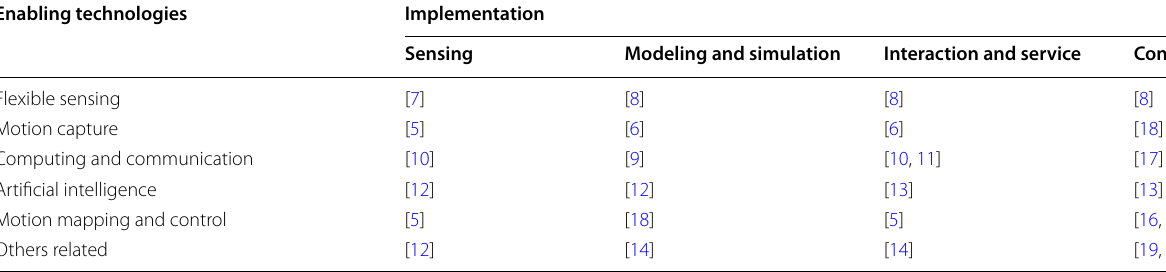
Table 1 Illustration of implementations supported by typical enabling technologies Enabling technologies